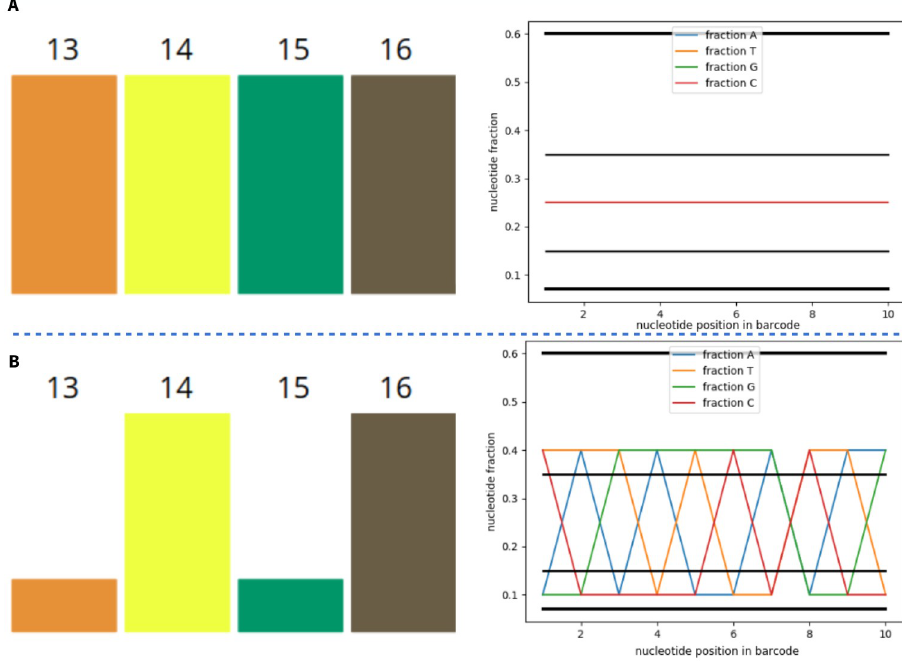
Fig 8. Changing the ratio in a set of barcodes. In the example of set 1, concentrations of 1:1:1:1 (A) changed to 1:4:1:4 (B) lead to an unbalance of the set from the initially perfectly balanced state. To check the decrease in the share of undecoded data generated by ZebraCall in the case of more than 2 unrecognized nucleotides in the barcode reading, we used the data recovery script (https://github.com/gateswell/SplitBarcode). In one of our runs in PE150 mode on a single lane, we received 2.4 GB and 2.5 GB for forward and reverse reads of undecoded files, respec- tively, comprising no more than 2% of the total data from this lane–this is the usual proportion for a well-passed run on MGISEQ-2000. We varied the parameters of the number of mis- matches (2, 3, and 4) from the list of barcodes with which the sequenced barcodes are com- pared (17 pieces used in the launch or all 128 barcodes), and determined how much the